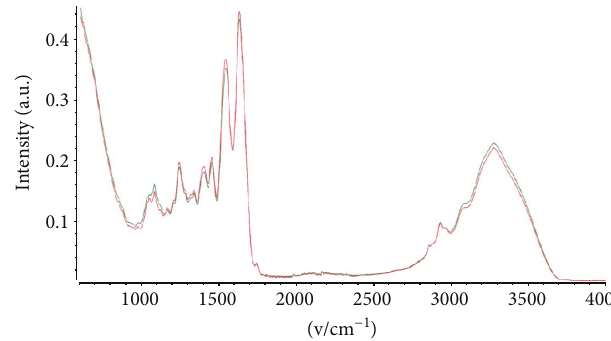
Figure 4: FT-IR spectra of the inner skin surface from fresh salmon samples.